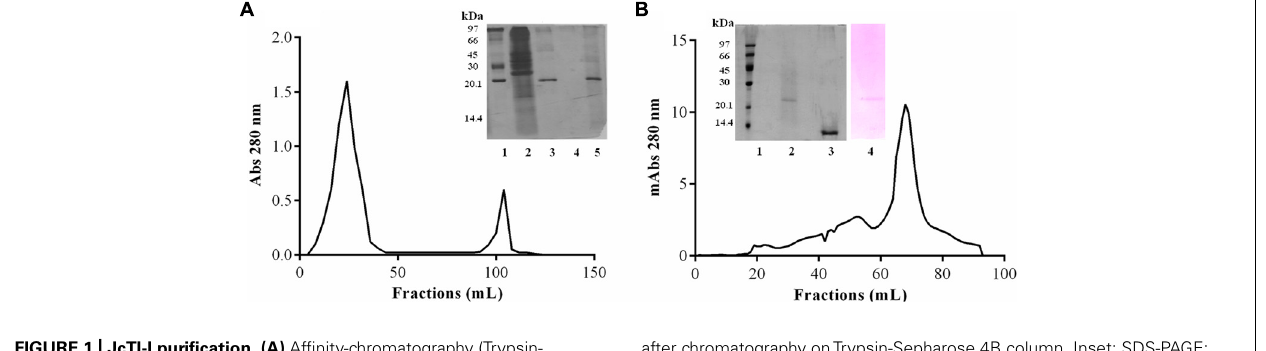
FIGURE 1 | JcTI-I purification. (A) Affinity-chromatography (Trypsin- Sepharose 4B column). Inset: SDS-PAGE: (1) molar mass markers; (2) crude extract; (3) 2.5%TCA fraction; (4) unbound fractions; (5) bound fractions. (B) Size exclusion chromatography (Sephacryl S-200 column) of JcTI-I purified